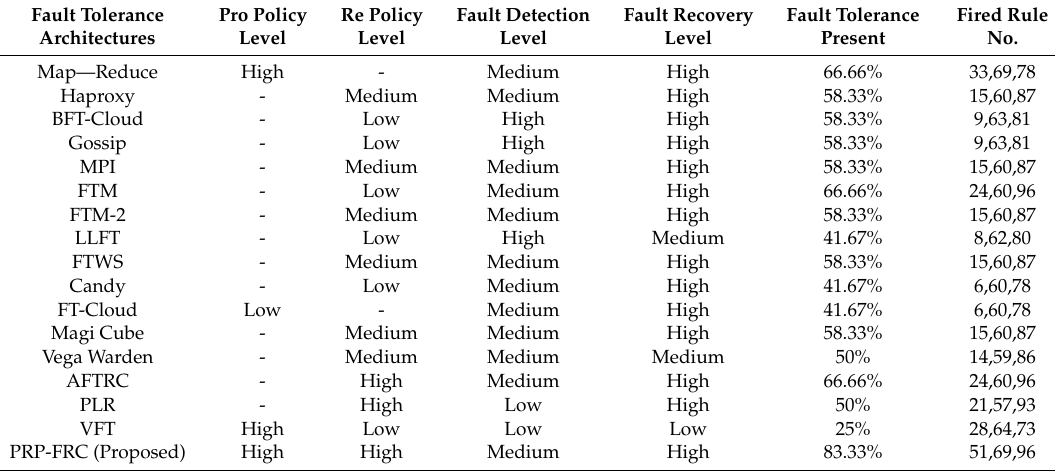
Table 12. Evaluation report of the FT capabilities of various architectures, compared to the proposed architecture of PrP_FRC by using the FIS (4)